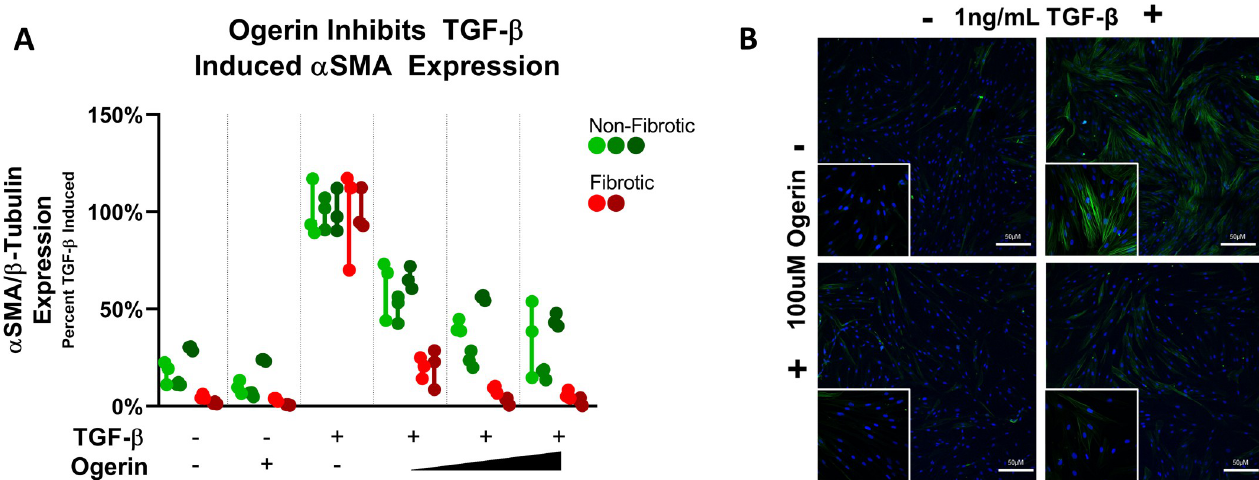
Fig 1. Ogerin inhibits TGF- β induced myofibroblast differentiation in primary human lung fibroblasts in a dose dependent manner. A: Primary human lung fibroblasts derived from donors with non-fibrotic or IPF diagnosis co-treated with 1ng/mL TGF- β and/or 50–150 μ M Ogerin for 72 hours. Whole cell lysates were analyzed for α SMA expression level via Western Blot. α SMA Band expression standardized to β -Tubulin, expressed as percent TGF- β induced. n = 3 per donor per treatment group, dots representative of technical replicates with bars representative of technical replicate range. Statistics omitted for clarity, individual plots with statistical analysis provided in S1 Fig. B: Primary human lung fibroblasts (Non-Fibrotic Donor #1) grown on glass microscope slides co-treated with 1ng/mL TGF- β and/or 100 μ M Ogerin for 72 hours. Cells fixed, permeabilized and stained for α SMA (Green) and nuclei (DAPI, Blue). Representative confocal images with 50 μ M scale bar shown in 200x image, and 400x inset. Full dataset provided in S2